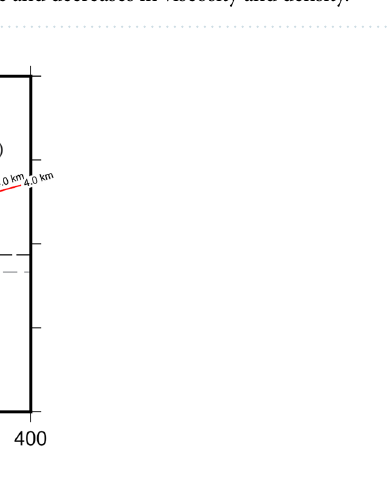
Figure 6. Fluid molar volume, viscosity, density and buoyancy calculated using various Equations of State and modified-LBC method and surface temperature of 20 ◦ C 12,13 . Blue and black lines represent values calculated using PR78, SRK and Reidlich–Kwong EoS at T s = 0 ◦ C and 20 ◦ C, respectively 14–16,19 . Blue dashed lines represent supercritical-dense liquid and dense liquid–liquid phase transitions for T s = 0 ◦ C. Black dashed lines represent gas-supercritical phase transition for T s = 20 ◦ C (see Fig. 7). The change from liquid to gas for all fluids is marked by an exponential increase in molar volume and decreases in viscosity and density.